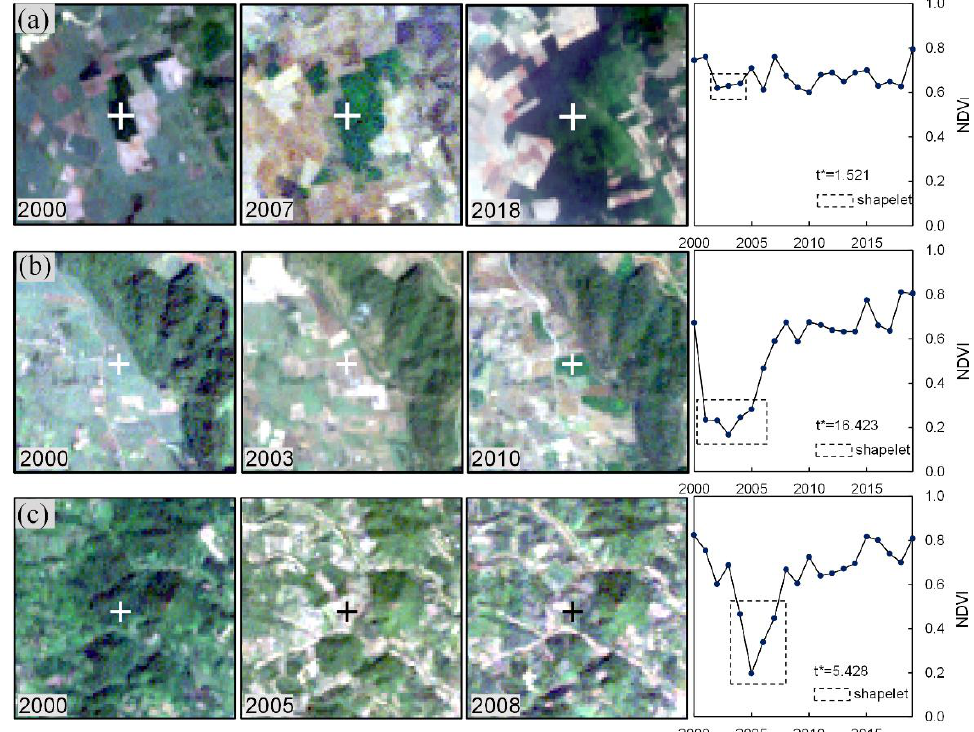
Figure 3. Inter-annual NDVI time series with related Landsat imagery (RGB = 3-2-1 for Landsat TM/ETM+, RGB = 4-3-2 for Landsat OLI) for ( a ) rubber plantations that last for 20 years, ( b ) rubber plantations converted from cropland, and ( c ) rubber plantations planted after natural forests are cut down.